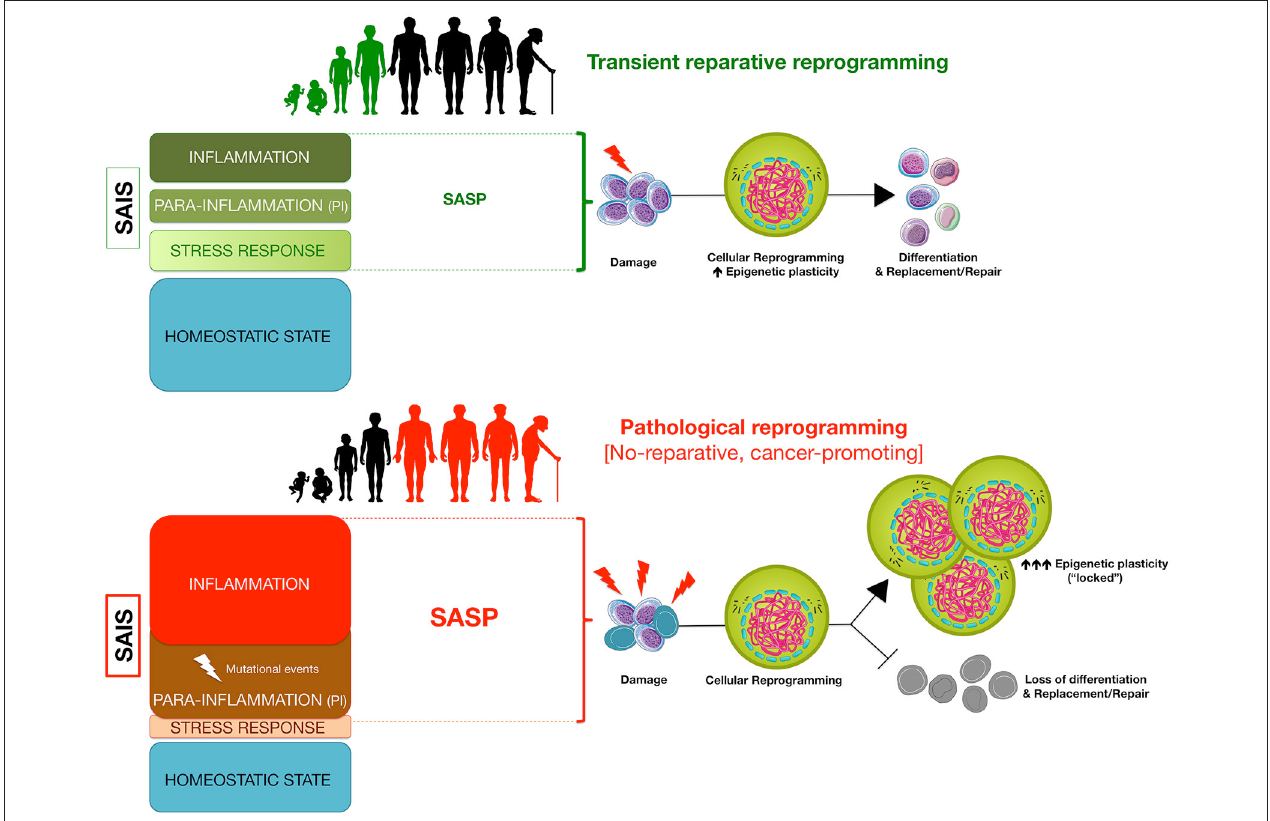
FIGURE 2 | Senescence-associated inflammatory signaling (SAIS)-regulated in vivo reprogramming: a threshold model of epigenetic plasticity in aging and cancer. The degree of senescence/inflammation deviation from the homeostatic state delineates a thresholding algorithm distinguishing beneficial vs. deleterious effects of in vivo reprogramming. First, transient activation of innate immunity and/or SASP components (e.g., IL-6) might facilitate reparative cellular reprogramming in response to acute inflammatory events. Second, NF κ B-dependent and NF κ B-independent (e.g., SIR) para-inflammation switches might promote a long-lasting but reversible refractoriness to reparative cellular reprogramming. Third, chronic SASP might lock cells into highly plastic epigenetic states disabled for reparative differentiation